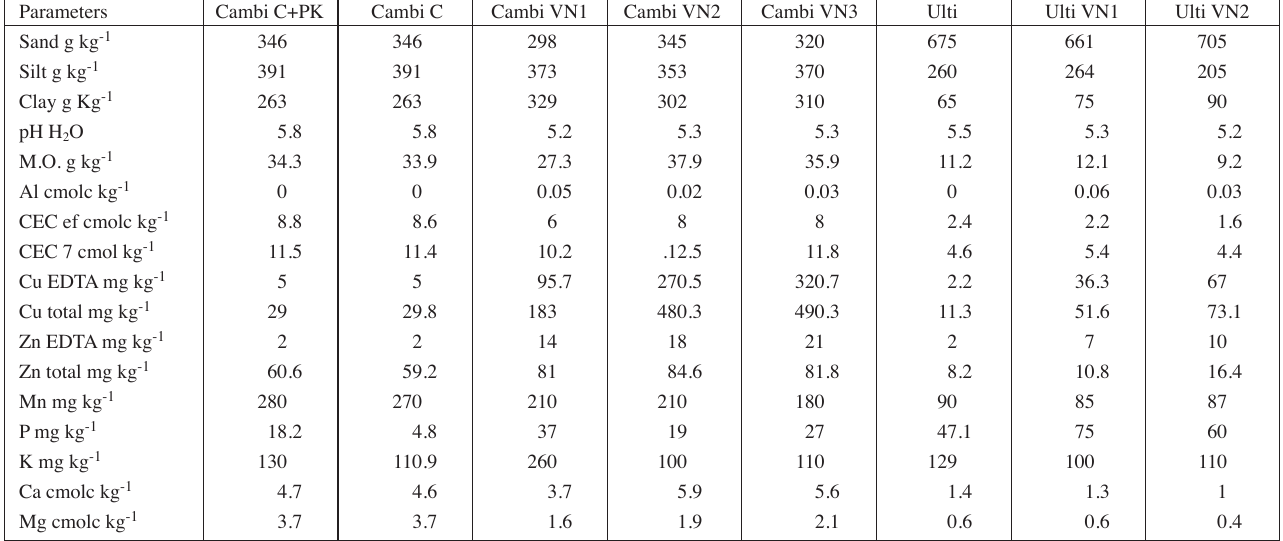
Tab. 1: Chemical and physical properties of vineyard soils with application of Cu-based fungicides.